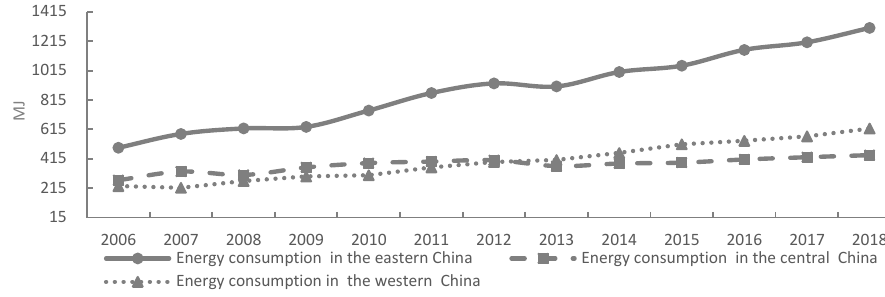
Figure 4. Estimation of the energy consumption of tourism by regions of China, 2006 to 2018. Note: Data is calculated and processed from this article.